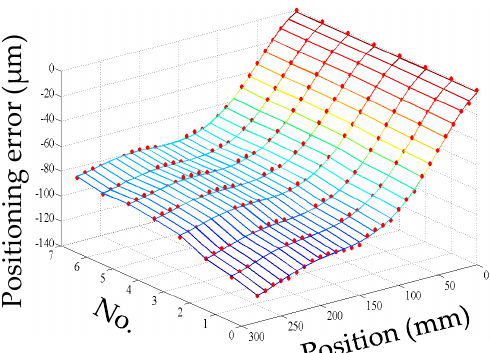
Figure 12. The fitting results of the MLR model (measured positioning error marked with dots) in experiment I.